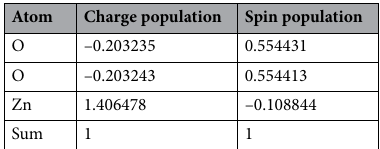
Table 1. Mulliken charge and spin population of [ Zn 2 + . . . O2 . −